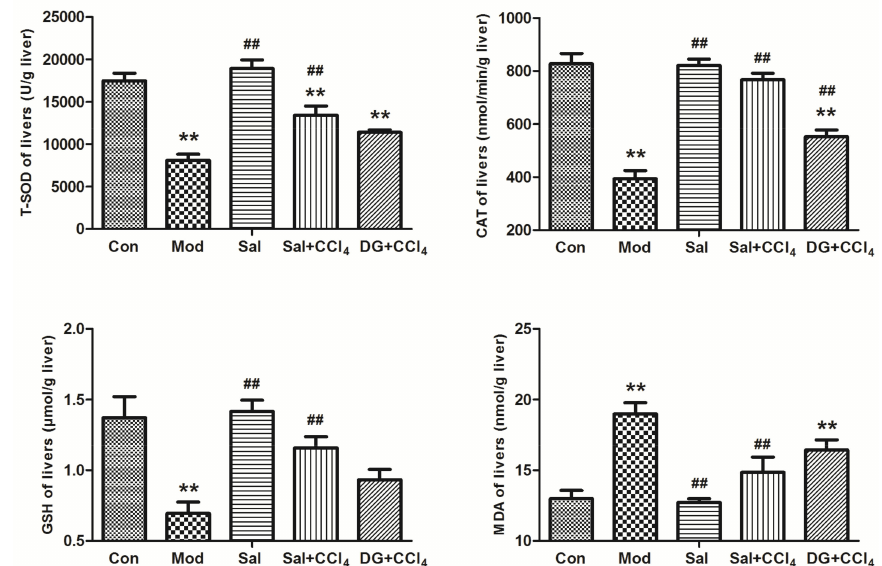
Figure 3. Salidroside balanced liver antioxidant system for oxidative stress resistance in mice. The vital antioxidases, namely, TSOD and CAT, nonenzymatic antioxidant GSH, and lipid peroxidative